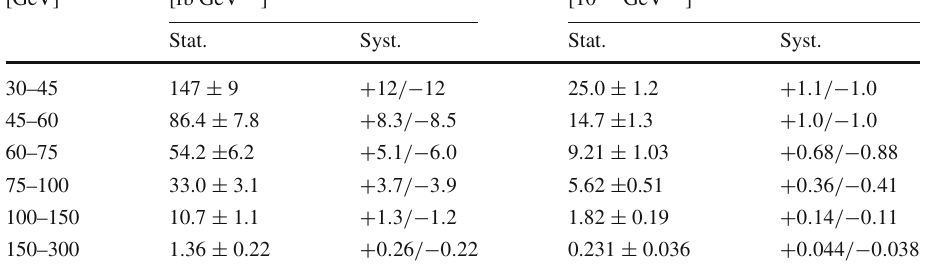
normalised unfolded differential ¯ tq production cross-section as a function of p T ( ˆ j ) at particle